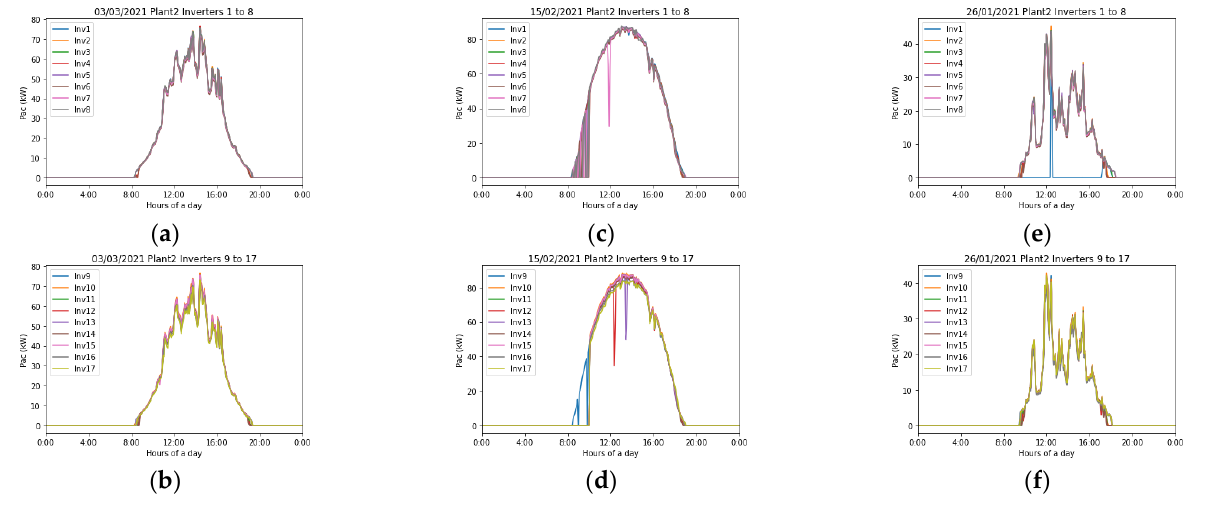
Figure 16. P ac corresponding to inverters of plant 2 on 3 March 2021 ((a) for inverters 1 to 8, and (b) for inverters 9 to 17), 15 February 2021 ((c) for inverters 1 to 8, and (d) for inverters 9 to 17) and 26 January 2021 ((e) for inverters 1 to 8, and (f) for inverters 9 to 17).